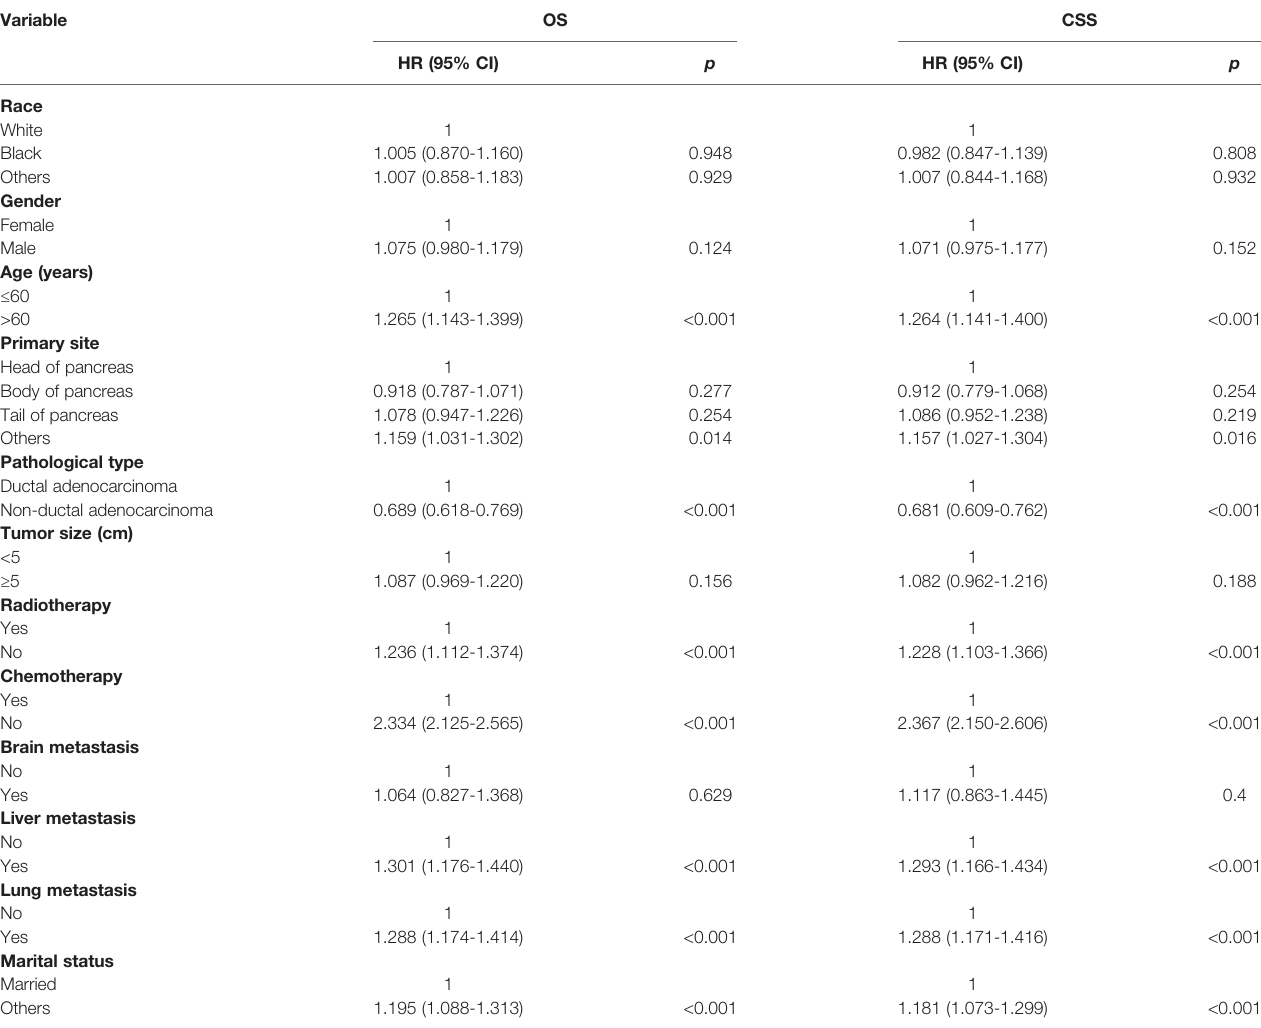
TABLE 2 | Univariate Cox analysis of variables in pancreatic cancer bone